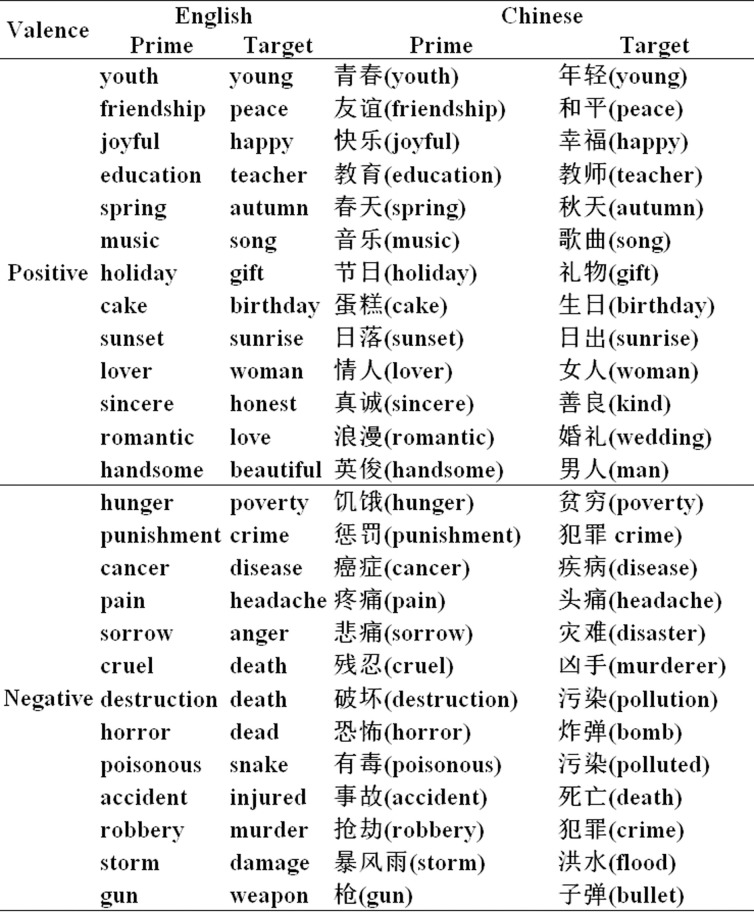
The stimuli at each treatment level of language by valence in Experiment 1.